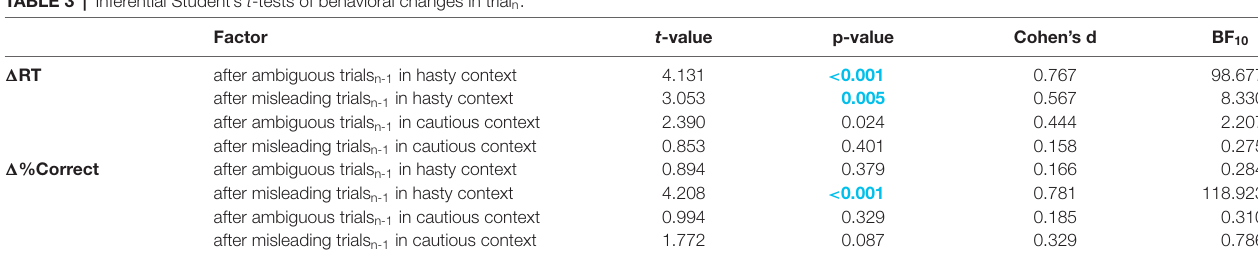
TABLE 3 | Inferential Student’s t -tests of behavioral changes in trial n